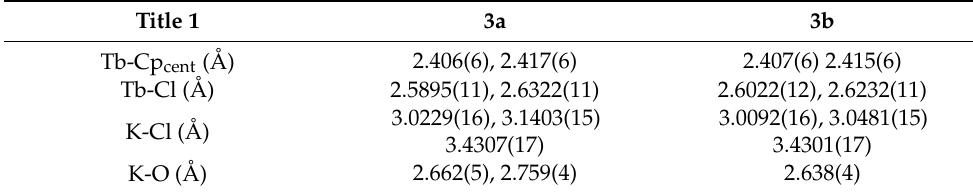
Figure 2. The general view of 3b in representation of atoms by thermal ellipsoids ( p = 50%). The carbon atoms of THF are omitted for clarity. Table 1. Selected structural parameters of complexes 3a and 3b